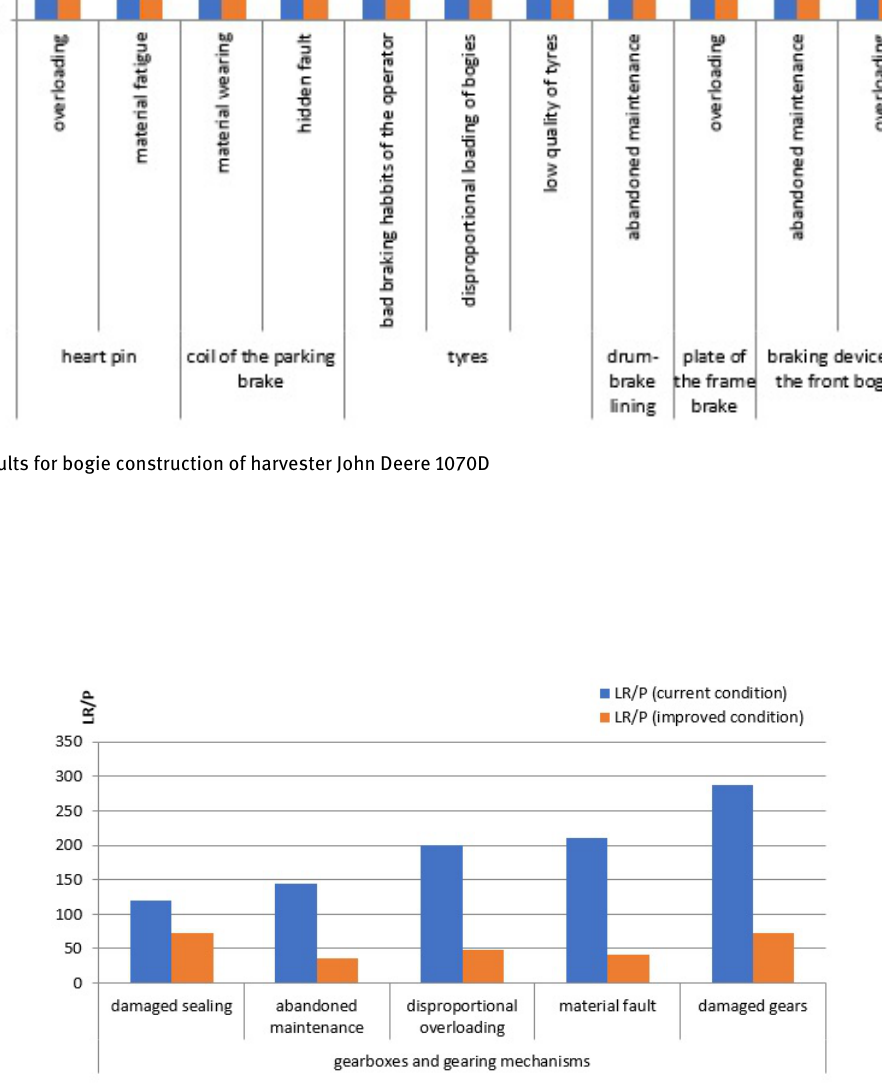
Figure 2: FMEA results for gearboxes and gearing mechanism of harvester John Deere